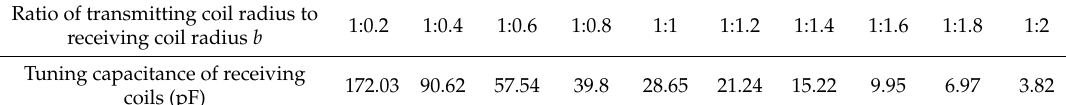
Table 2. Radius ratios and values of the corresponding capacitance.